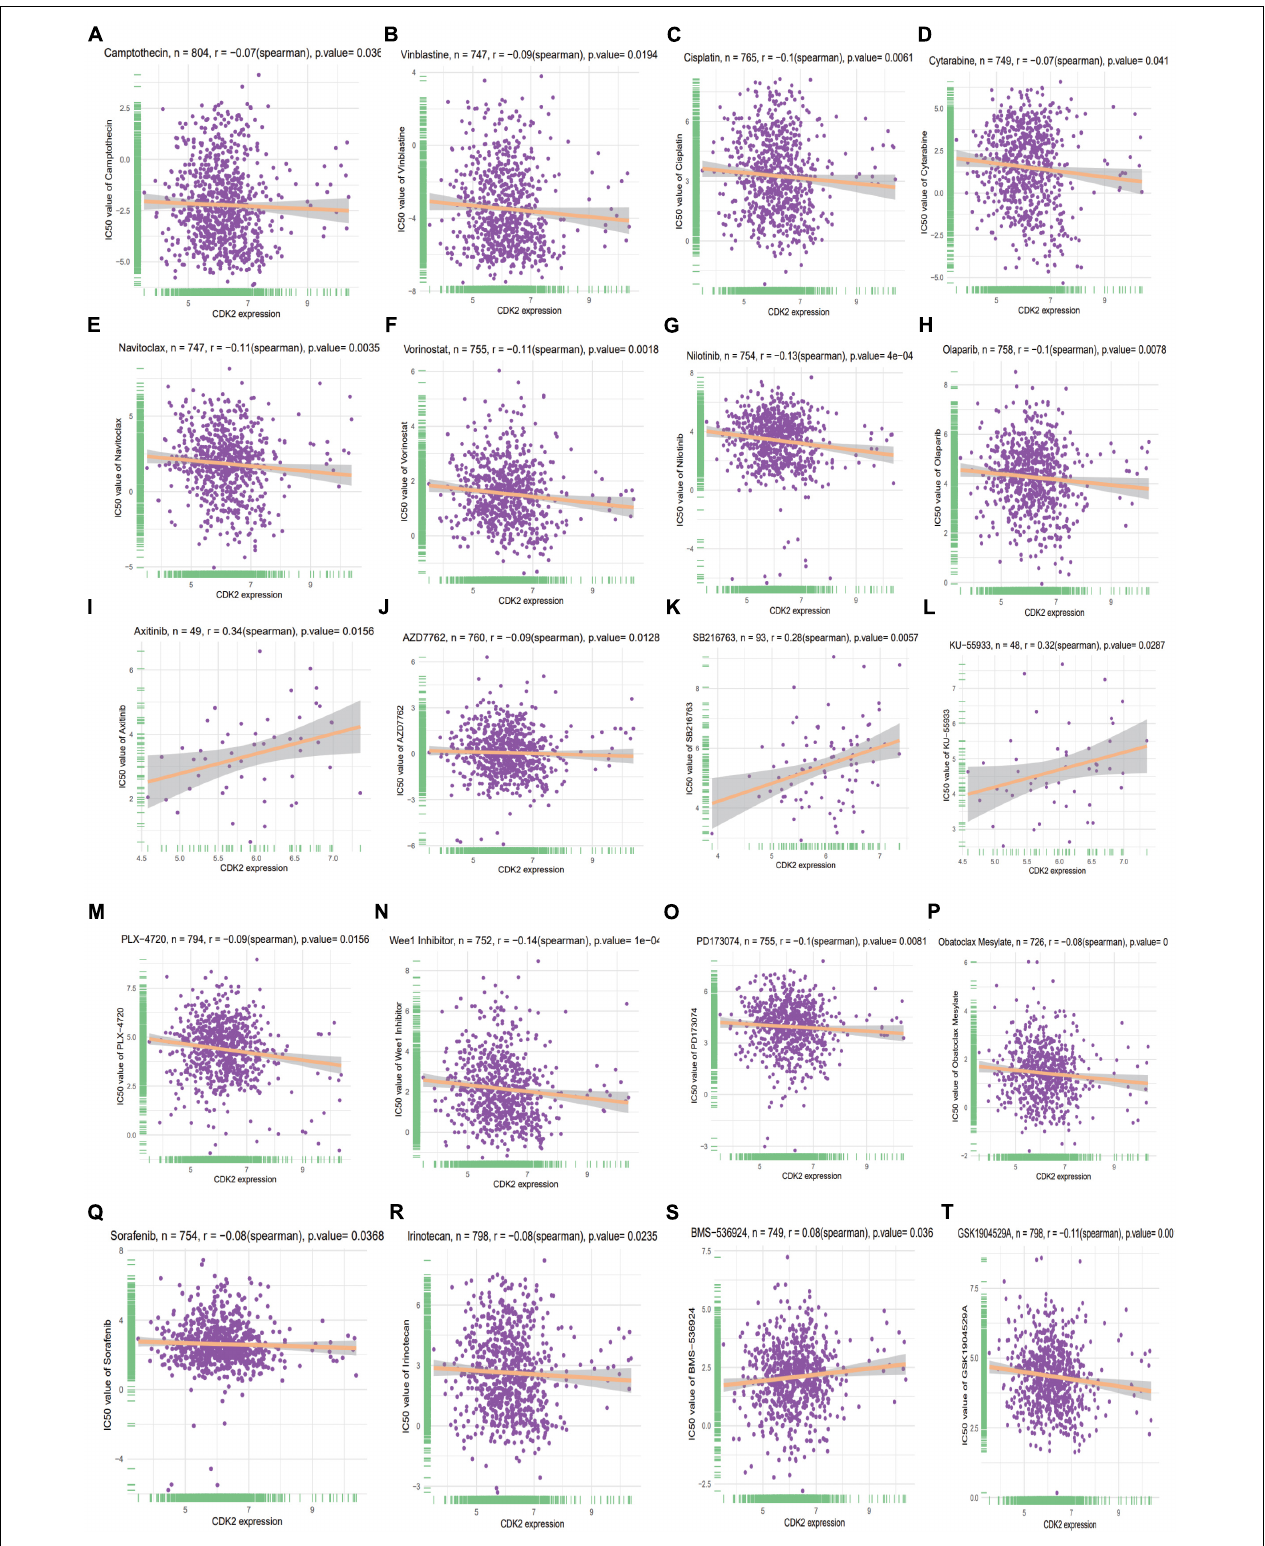
FIGURE 12 | The top 20 anti-tumor drug resistance studies related to CDK2 (A–T) .